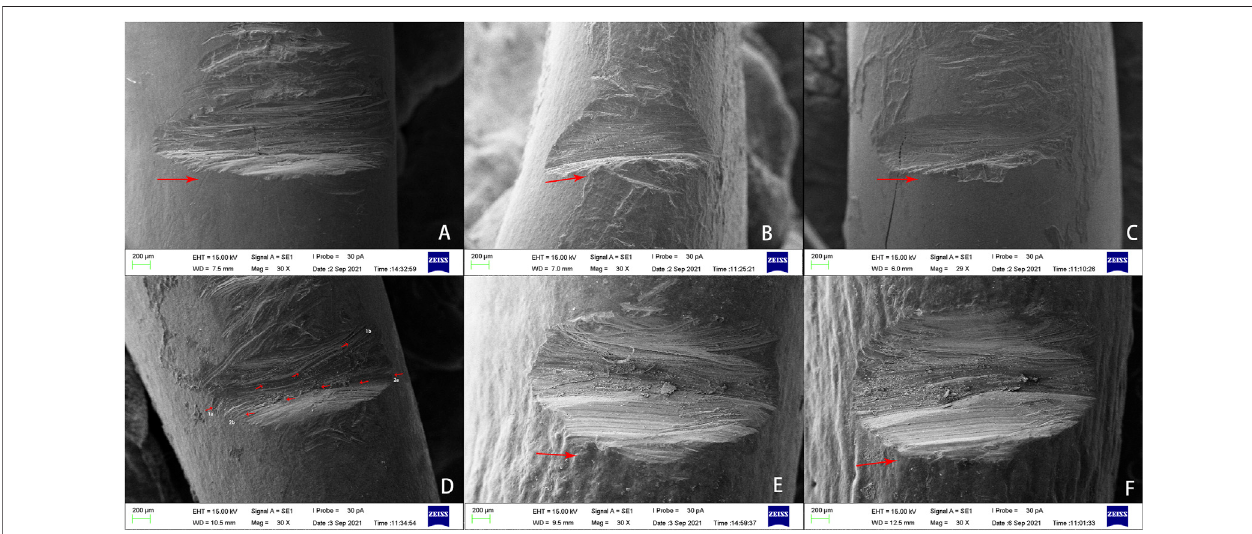
FIGURE6| SEMmicrographsoftheexperimentallyproduced notches. (A,B,C) Notches made byrepeatedly passinganunretouched fl akeintothegrooves inthe same direction (arrows indicate the direction of the movement); (D) Notch produced by a to-and-fro movement of an unretouched fl ake; notice the different orientations of the striations; (E,F) Notches made by repeatedly passing a bifacially retouched fl ake into the grooves in the same direction (arrows indicate the direction of the movement). Notice the U-shaped cross-section and the presence of multiple steps on the fracture walls. Scales: 200 μ m.